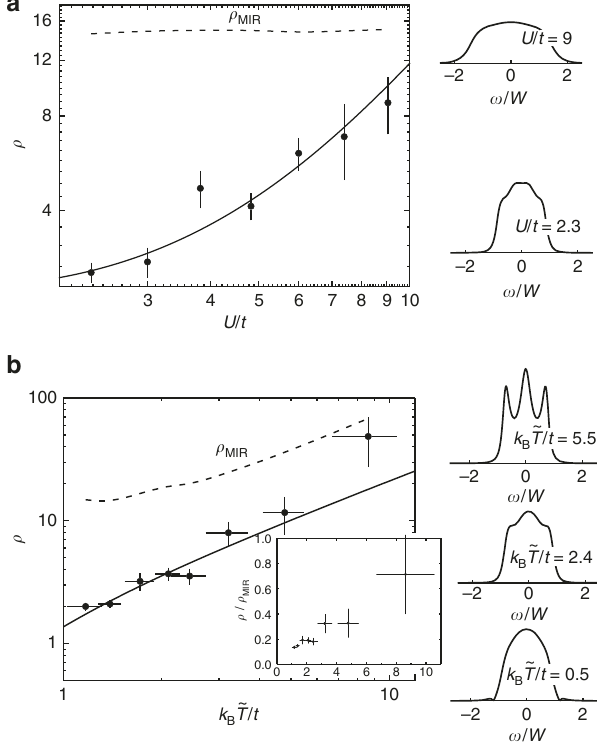
Fig. 4 Interaction and temperature dependence of the dimensionless resistivity ρ . These data correspond to those shown in Figs. 3 and 5. a Interaction scaling, fi t (solid line) fi t to DMFT scaling law U 2 with reduced χ 2 = 0.99. b Temperature scaling, fi t (solid line) to DMFT scaling law T with reduced χ 2 = 1.76. The vertical error bars include the uncertainty in the fi t used to determine τ t and the uncertainty in n dwd from the measurements of N and T . Orthogonal distance regression is used for fi tting to accommodate the horizontal error bars in b . The plots along the right side of the fi gure show the local spectral function A ( ω ) using a constant vertical scale, and the energy ω relative to the Fermi energy is in units of the half bandwidth W . A ( ω ) is calculated at U / t = 2.3 for b . The inset in b shows the ratio between the dimensionless resistivity and the MIR